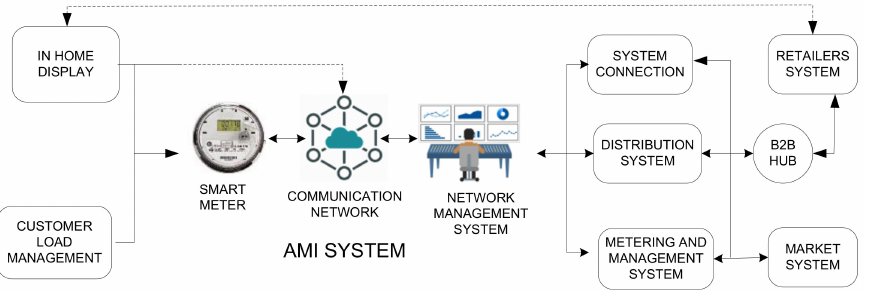
Figure 15. AMR and their functionalities in the